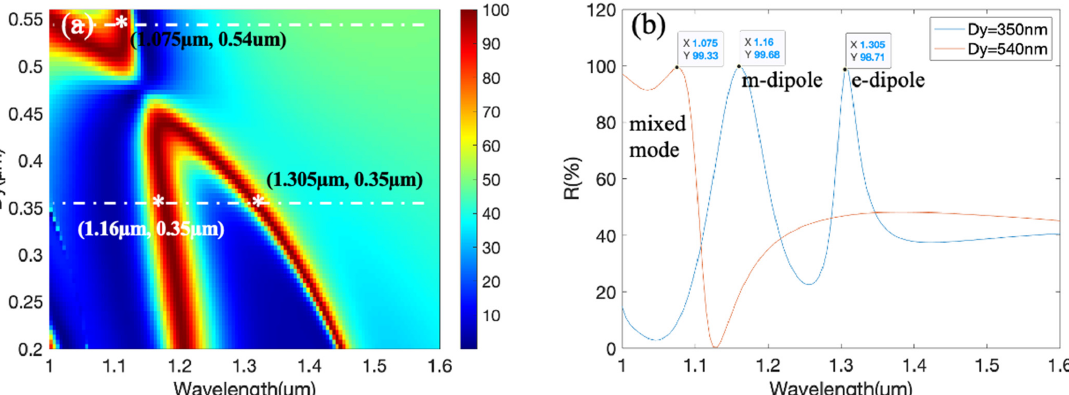
Figure 5. Dispersion of Si nanoholes: ( a ) Reflectance as a function of wavelength and D y. ( b ) Reflectance when D y equals 0.35 µm and 0.54 µm, which is marked by the white dash line in ( a ). Here, the heights of nanoholes are constant H = 200 nm, D x=0.485 µm, and the lattice period P is 600 nm.